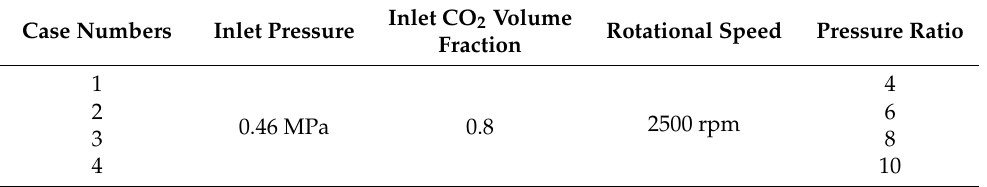
Table 6. Setting parameters of simulations with various pressure